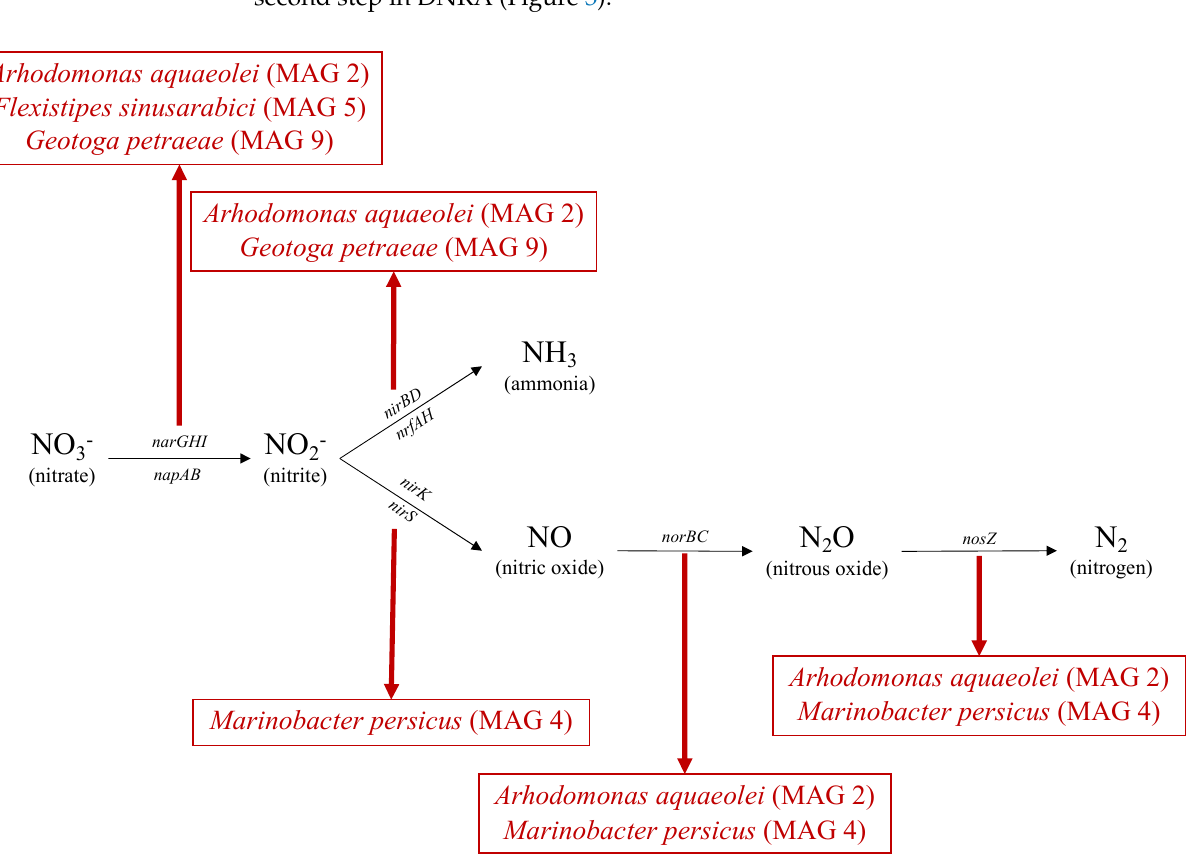
Figure 3. Genes present within MAGs for dissimilatory nitrate reduction (top branch) and denitrification (bottom branch).